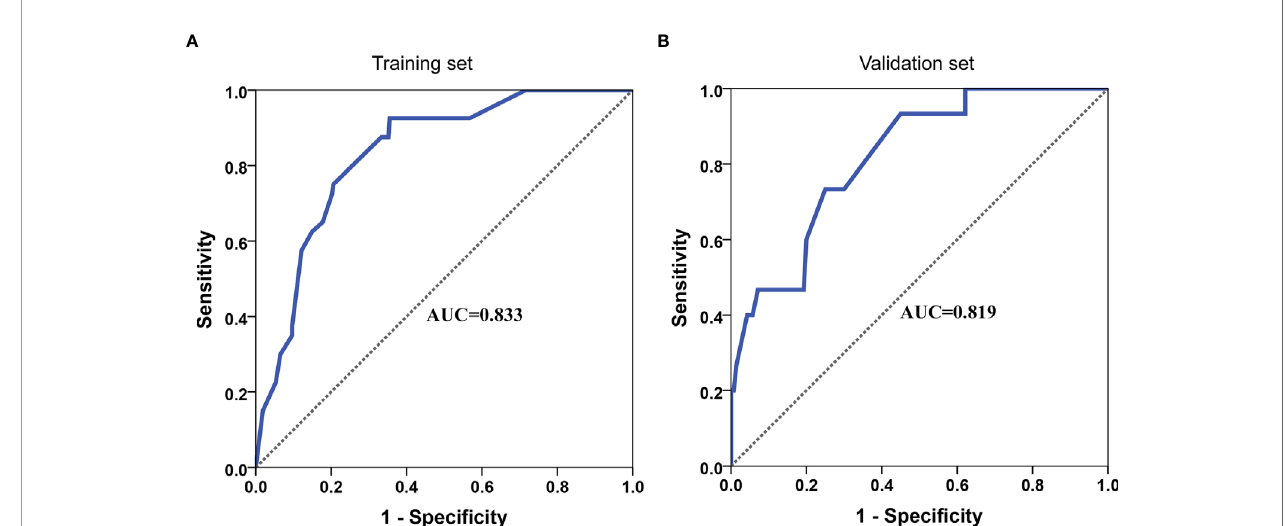
FIGURE 4 | ROC curve of the nomogram for predicting LVI in training set (A) and validation set (B) .